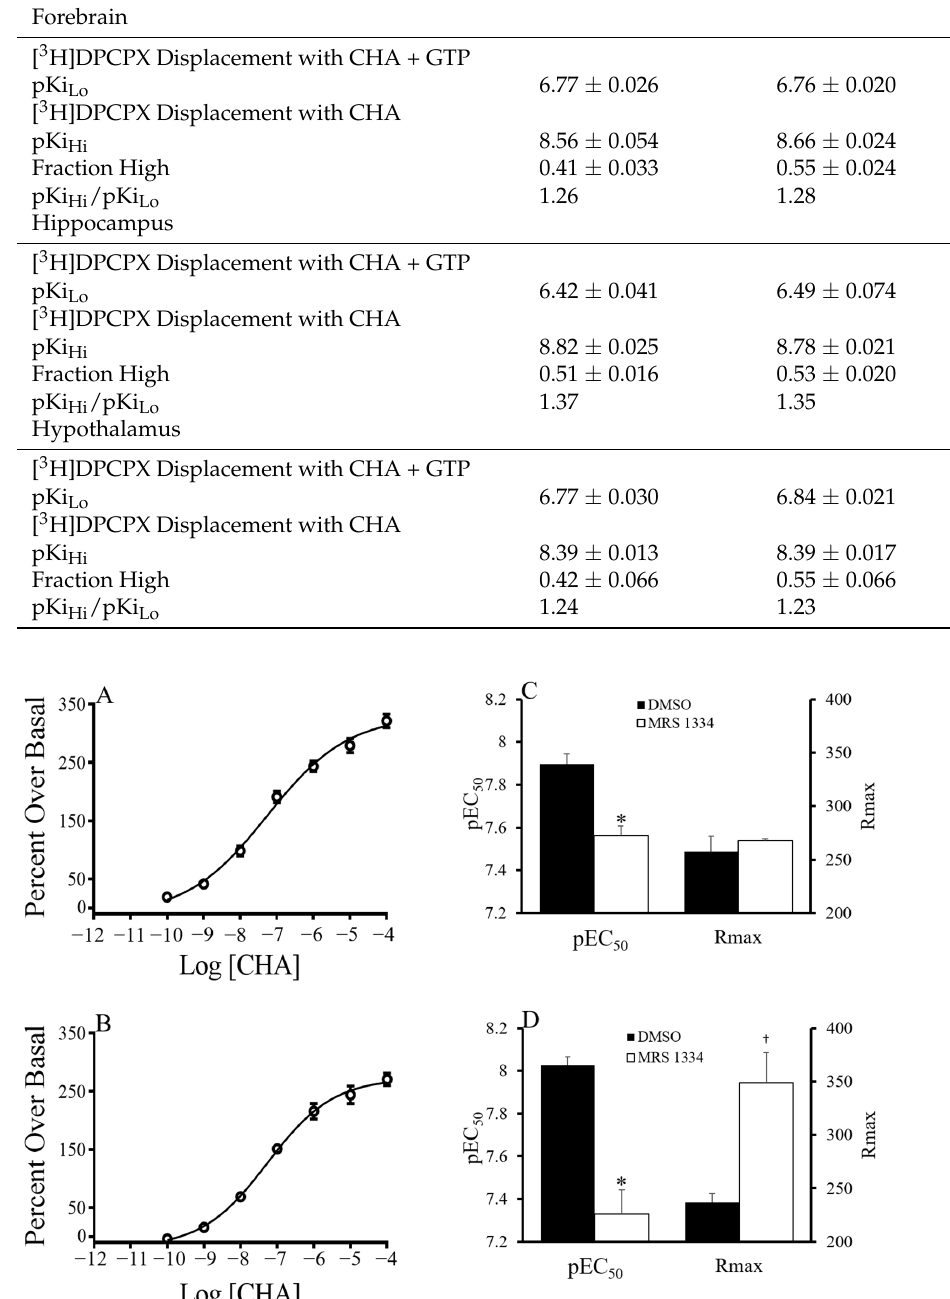
Figure 4. CHA (100 pM to 100 µ M)-induced GDP/GTP exchange measured by 35 S-GTP γ S binding in the presence of A 3 AR antagonist, MRS 1334 dissolved in DMSO. Inhibiting A 3 AR had no effect on the Hill slope of CHA-induced GDP/GTP exchange in the forebrain of summer (hillslope = 0.55 ± 0.042, 0.66 ± 0.024, n = 3, 3; DMSO, MRS 1334) ( A ) or torpid (hillslope = 0.61 ± 0.56, 0.56 ± 0.042, n = 3, 3; DMSO, MRS 1334) AGS ( B ), showing that the low Hill slope was not due to CHA binding to the A 3 AR at higher concentrations. MRS 1334 reduced the potency of CHA in summer ( C ) and torpid ( D ) tissues. In torpid tissue, preincubation with MRS 1334 increased Rmax when compared with DMSO ( D ). * p < 0.01, † p < 0.05 vs. DMSO, t